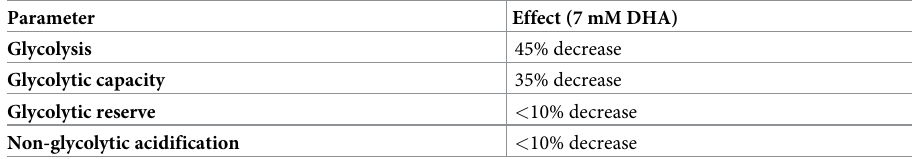
Table 2. Flux analysis summary for DHA-exposed HepG3 cells.